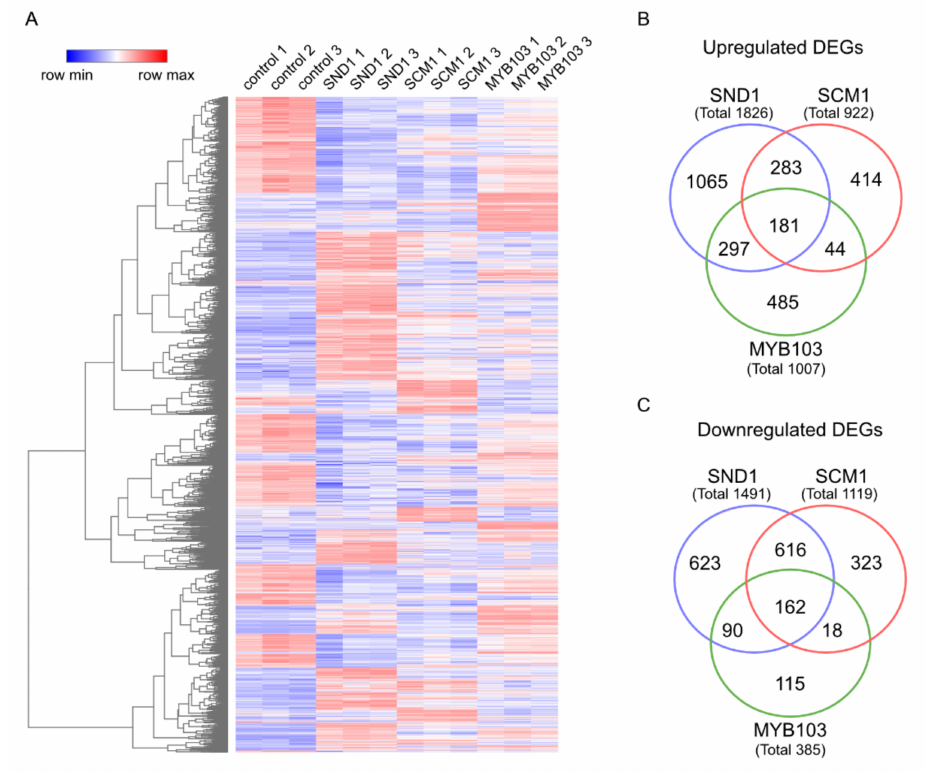
Figure 4. Transcript profiling of transcriptional network regulated by MsSND1, MsSCM1, and MsMYB103. ( A ) Heatmap of normalized counts (logCPM) of the 4716 genes that were differentially expressed (4-fold cutoff) in at least one sample compared to control infiltrations with an empty vector. Rows were hierarchically clustered by complete linkage and Euclidean distance. ( B , C ) Venn diagram of upregulated ( B ) and downregulated ( C ) DEGs with adjusted p -value < 0.05 and a minimum 4-fold